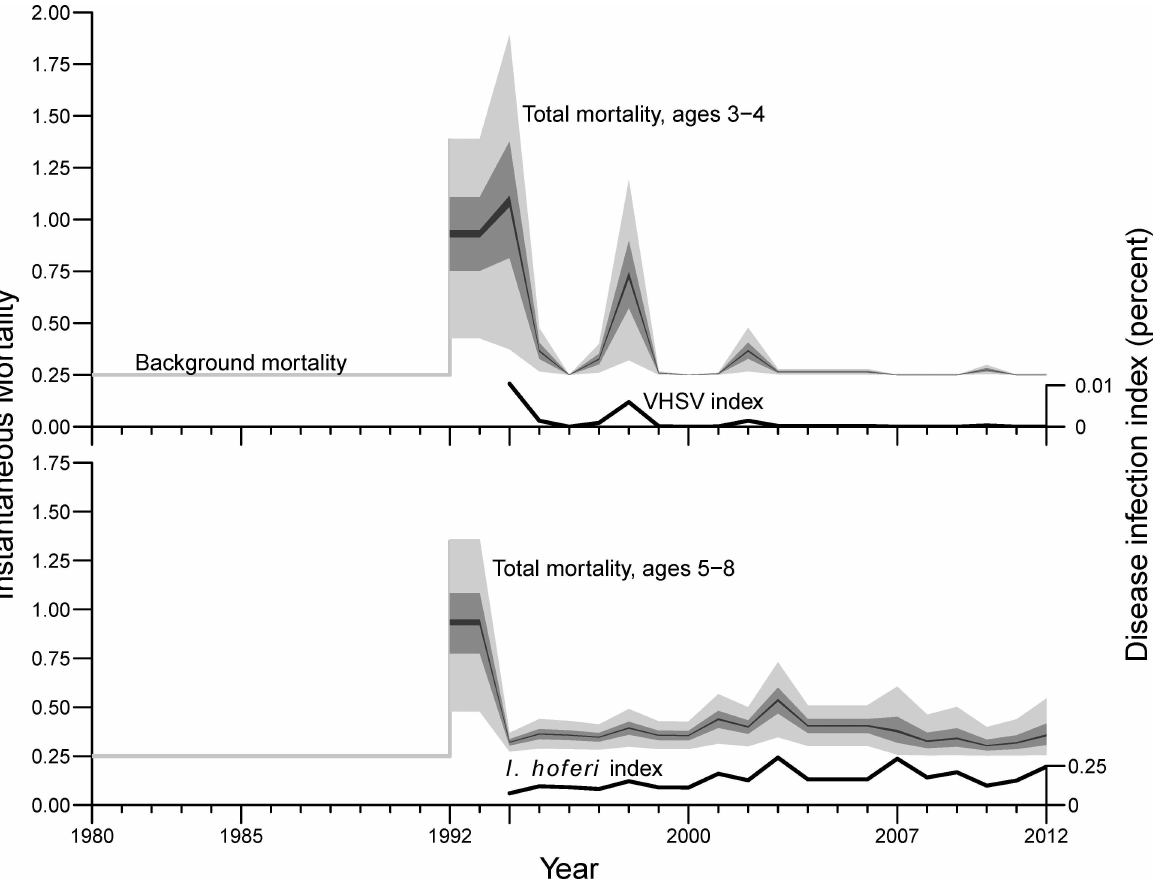
Fig 9. Total non-fishery mortality rates for herring of ages 3–8 in 1980–1991(assumed) and in 1992–2012(estimated). Posterior distributionsbegin in 1992 (light gray = 95% interval, darker gray = 50% interval, black = 5% interval) for model estimates of total non- fishery instantaneous mortality for ages 3–4 (top) and ages 5–8 (bottom). Lower black lines show the diseaseindex data for VHSV and I . hoferi infection(percent; right-handaxis). VHSV infectionwas observed to be zero in 2007–2009and 2011–2012, hence total instantaneous mortality in those years equals the assumed background level of 0.25